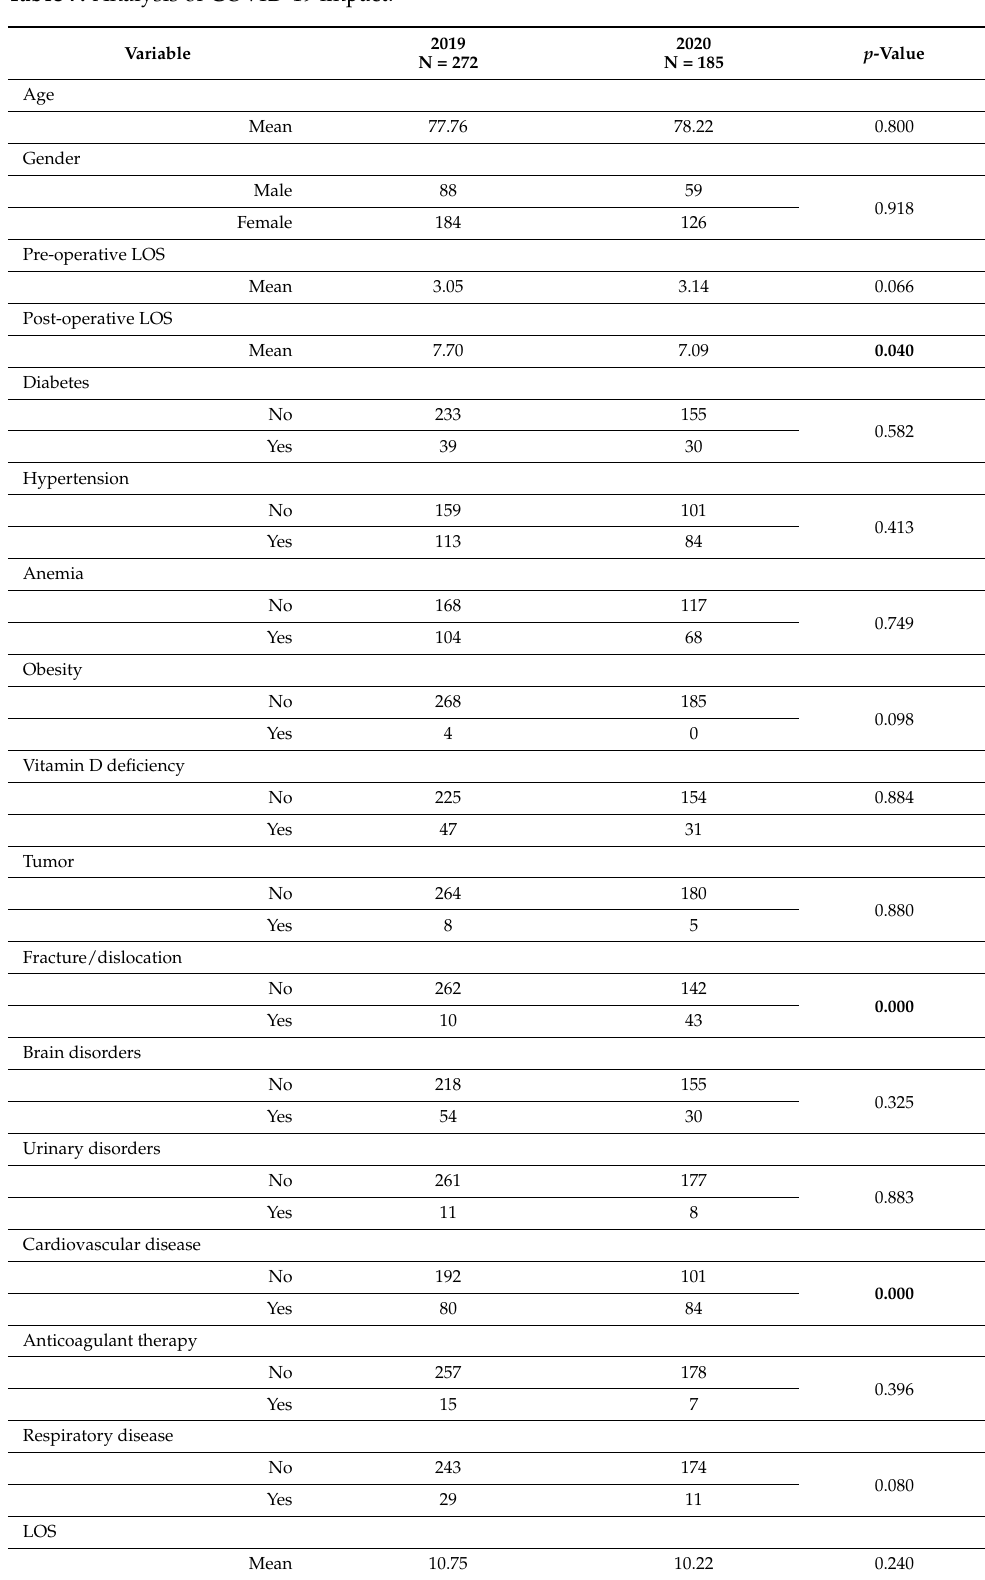
Table 7. Analysis of COVID-19